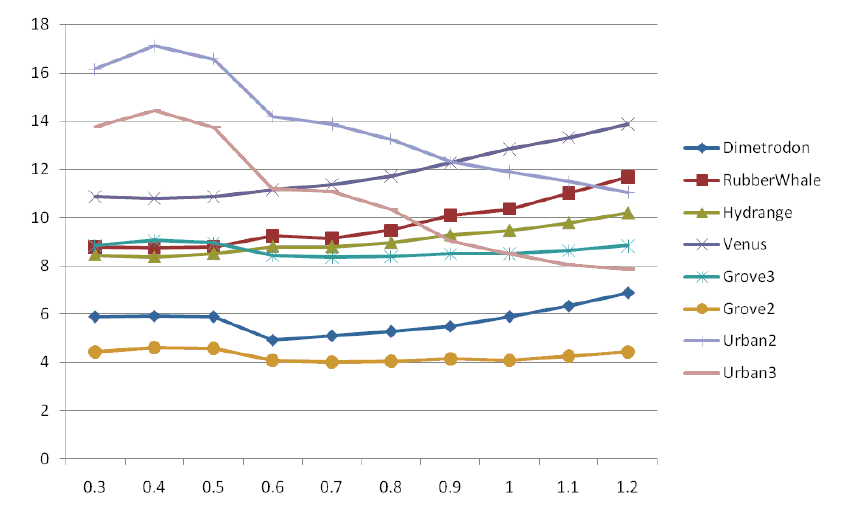
Figure 9. Average angular error for different σ